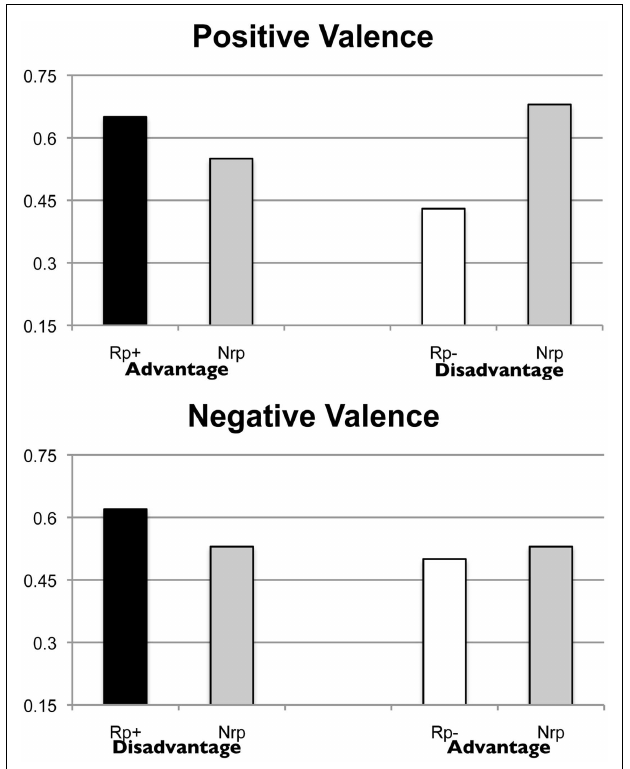
FIGURE 2 | Recall proportion for Rp + /Nrp and Rp − /Nrp items in Experiment 1, for the PositiveValence Condition (advantages received selective practice) (on the top), and the NegativeValence Condition (disadvantages received selective practice) (on the bottom) . In the PositiveValence Condition, we compared Rp + items (advantages) with Nrp advantage items, and Rp − items (disadvantages) with Nrp disadvantage items. Similarly, in the NegativeValence Condition, we compared Rp + items (disadvantages) with Nrp disadvantage items, and Rp − items (advantages) with Nrp advantage